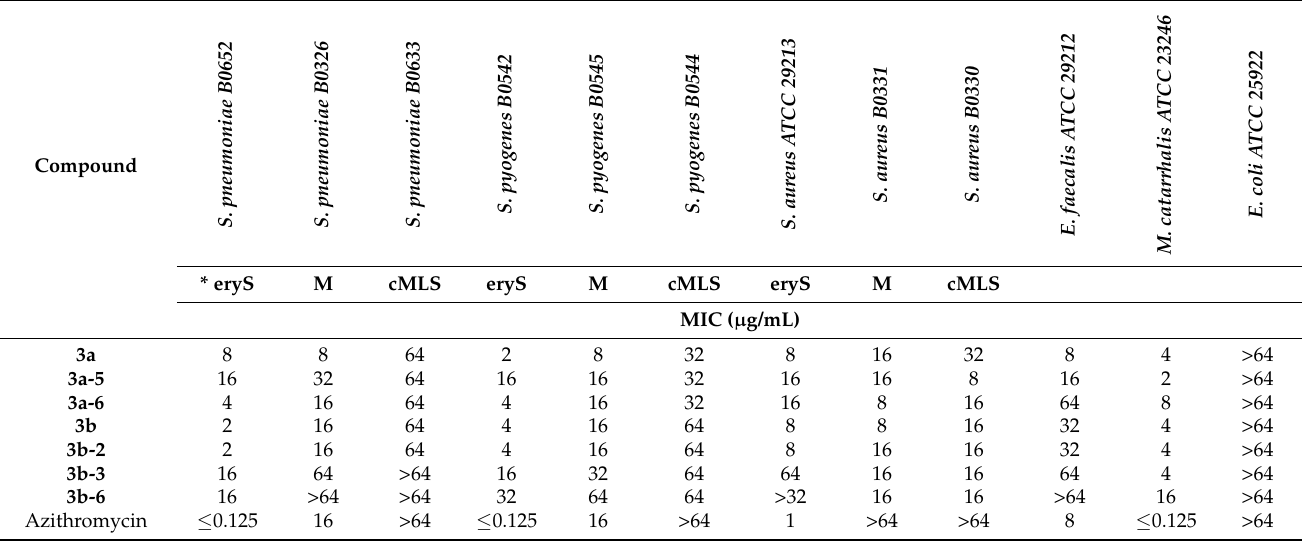
Table 2. In vitro antibacterial activity (MIC, µ g/mL) for macrozones, macrozone derivatives and azithromycin. A diverse panel of clinical isolates with known mechanisms of macrolide resistance and standard strains were